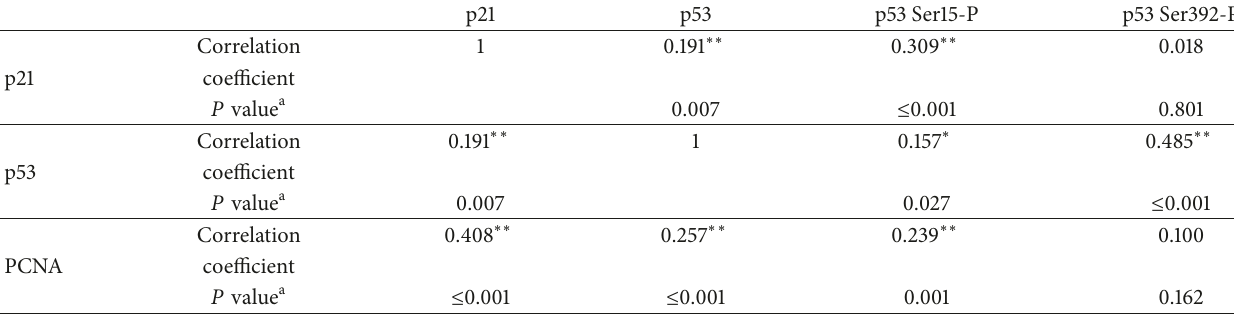
Figure 1: Expression of p53 Ser15-P as observed by IHC . Brown dots are the stained p53 Ser15-P–positive cells. Categories of < 1%, 5%, 20%, and 70% positive cells (PP) are shown under 100 × and 400 × magnification. Table 3: Correlation between p21, p53, and p53 serine-P expression in